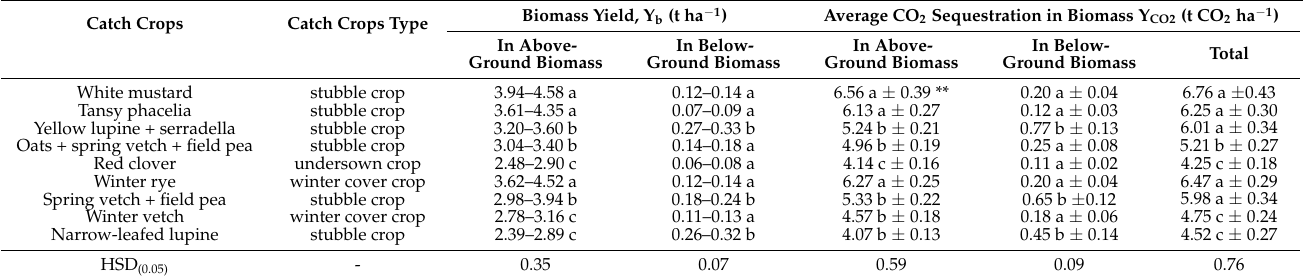
Table 1. Biomass yields and carbon dioxide sequestration by catch crops cultivated in Poland. Catch Crops Catch Crops